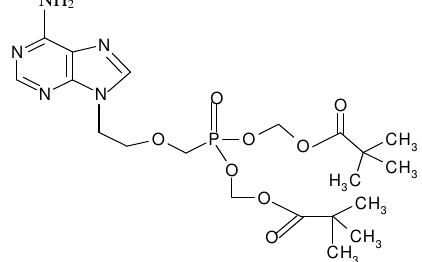
Figure 1 . Structure of adefovir